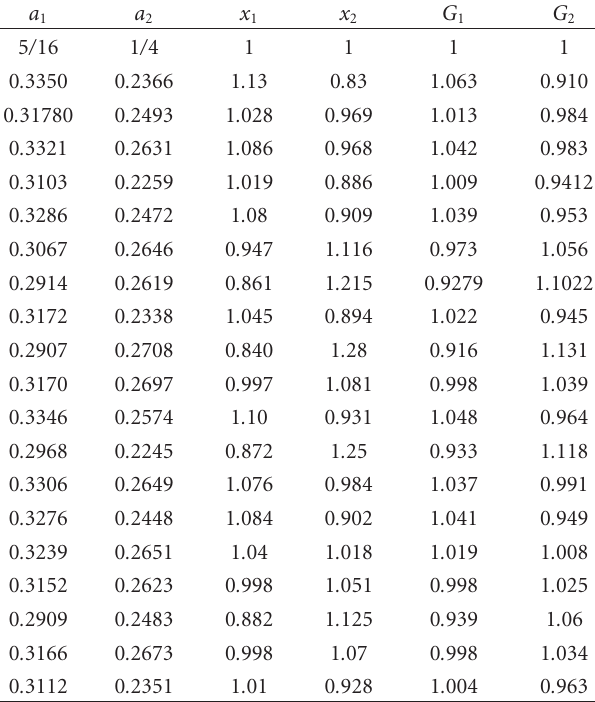
Table 1: Filter coe ffi cients and